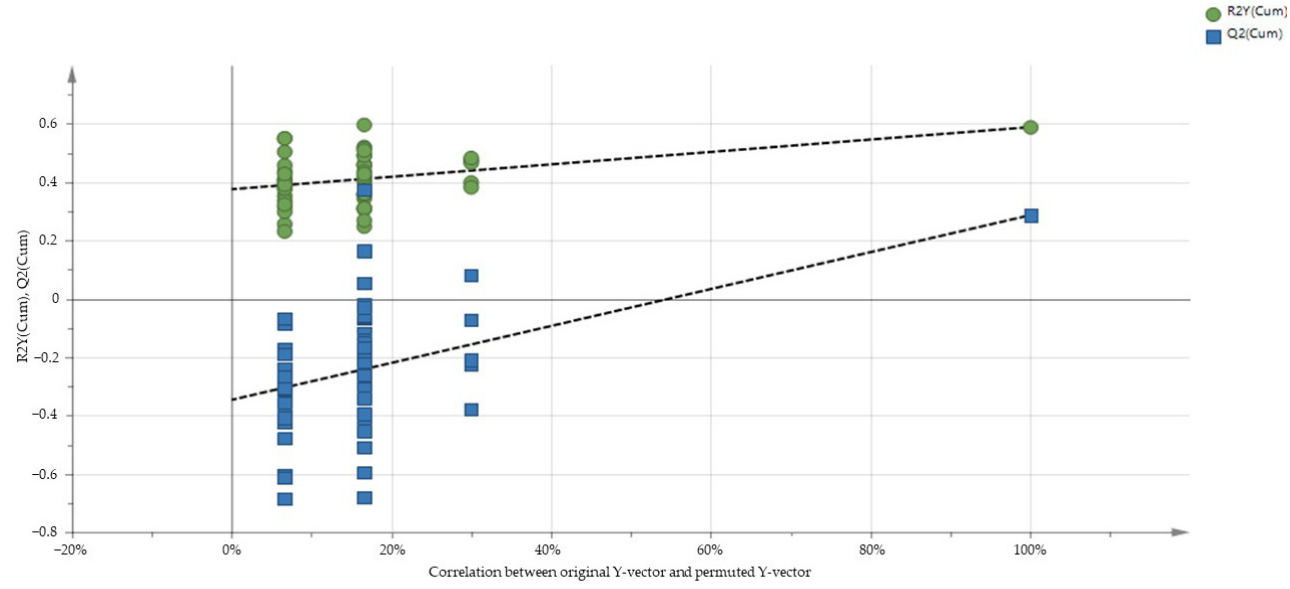
Figure A2. Permutation plot of the final OPLS-DA top model. This analysis recreates 50 models with permuted Y-values, shown to the left. The original model ´ s R 2 Y and Q 2 values are shown to the right from which a regression line is drawn through the permuted R 2 Y and Q 2 values to the vertical axis. A strong model has higher Q 2 and R 2 Y values than all of the permuted models and/or the Q2 regression line to intercept the vertical axis below zero. The plot shows the intercept of the regression line of the R2Y at 0.38 and Q2 at − 0.35.